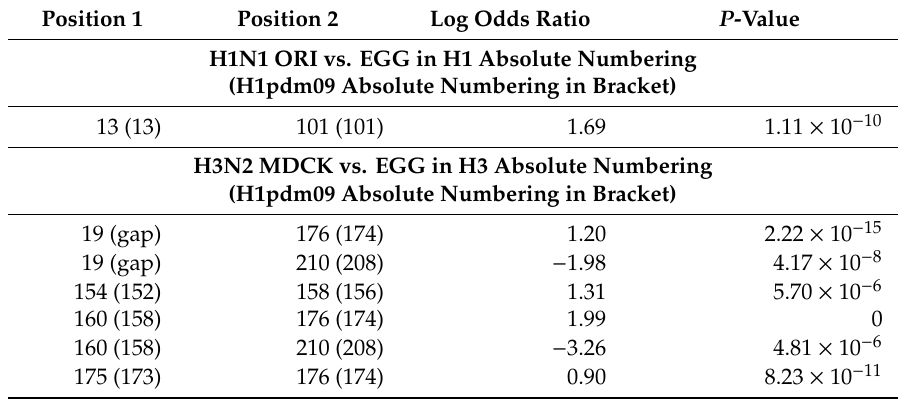
Table 3. Pairs of sites with significantly different association between passages after Bonferroni